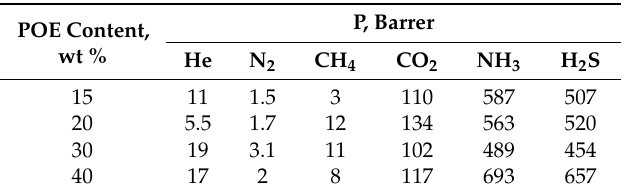
Table 1. Polymer permeability coefficient (P) for different single gases obtained at different POE block contents (measurements are given at the pressure of 1 atm ).